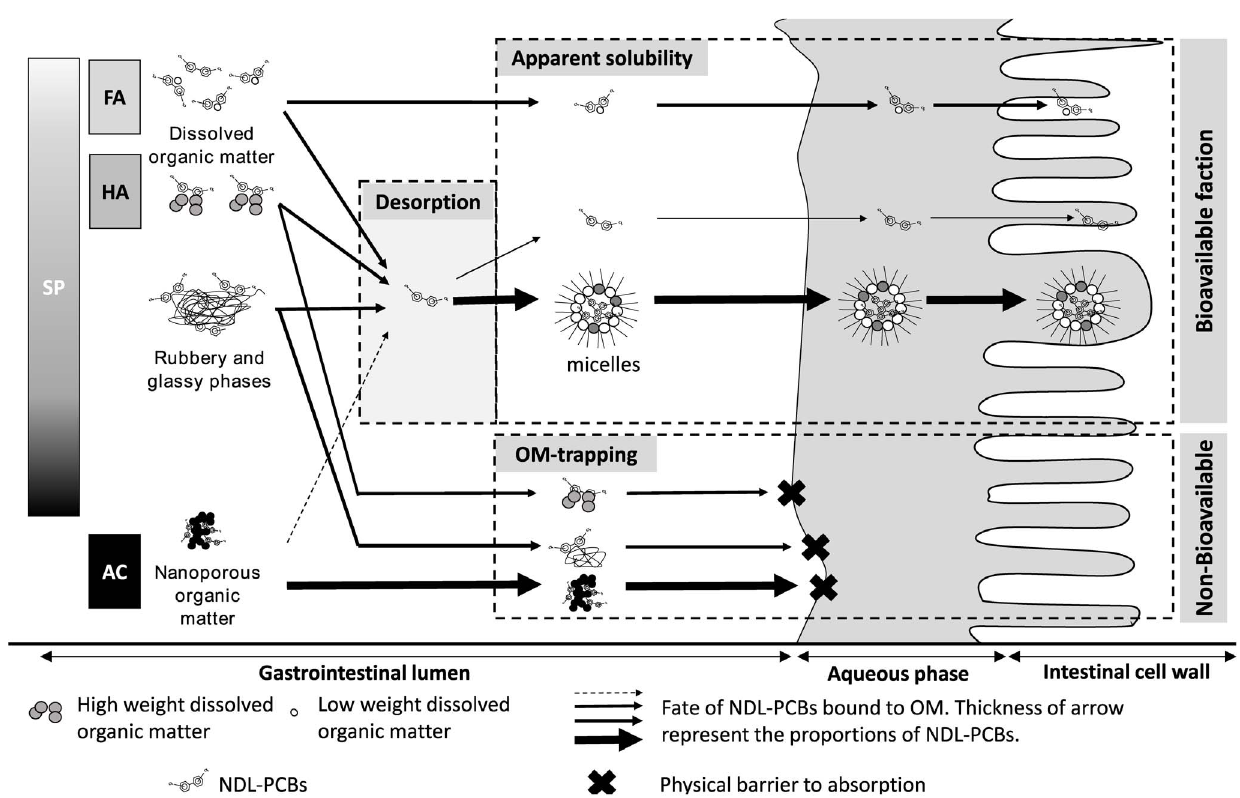
Fig. 3. Mechanistic approach of retention and bioavailability of NDL-PCBs bound to